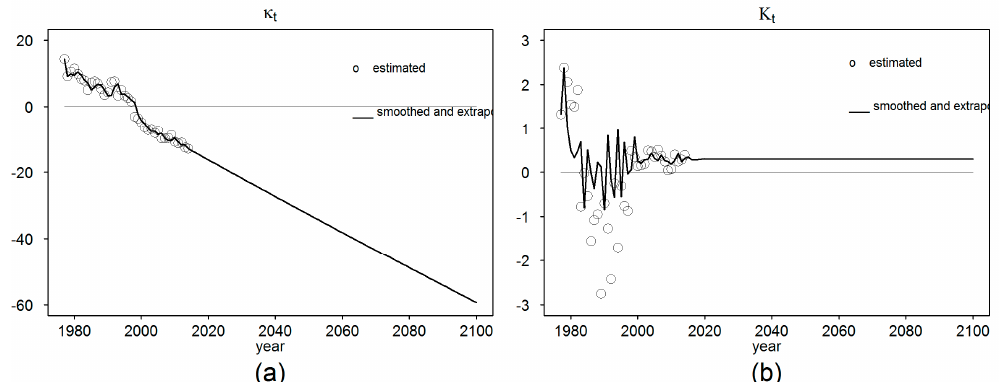
Figure 8 . Time components forecast: ( a ) the observed, smoothed and extrapolated 𝜅 (cid:3047) ; and ( b ) the Figure 8. Time components forecast: ( a ) the observed, smoothed and extrapolated κ t ; and ( b ) the results obtained with 𝐾 (cid:3047) . results obtained with K t